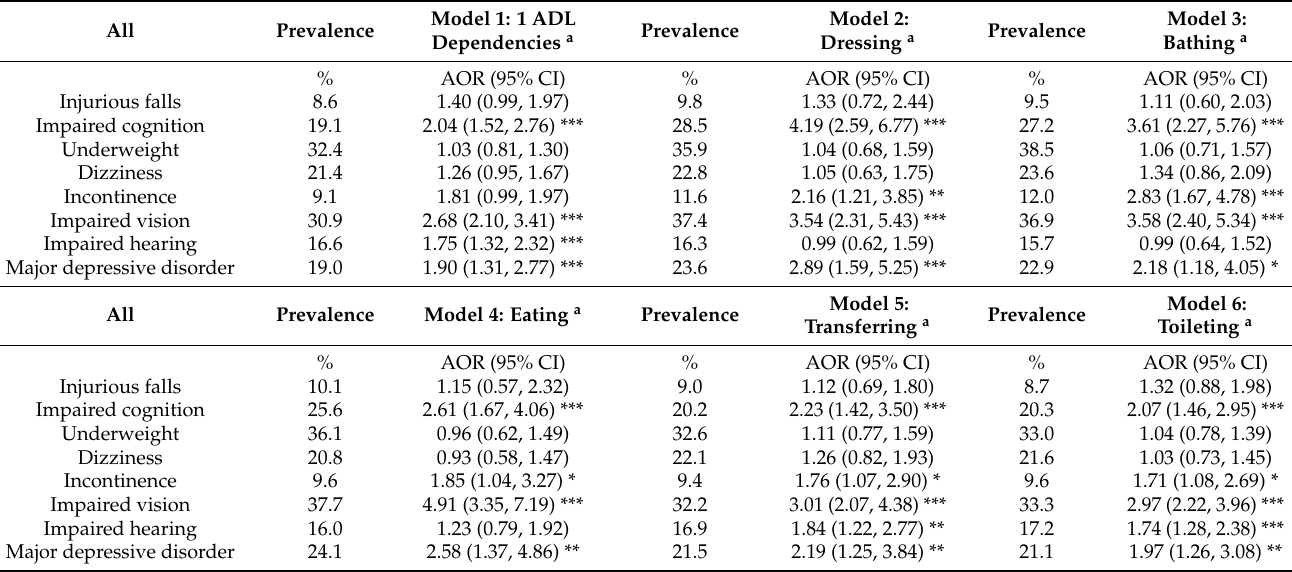
Table 4. Associations between geriatric conditions and Activities of Daily Living